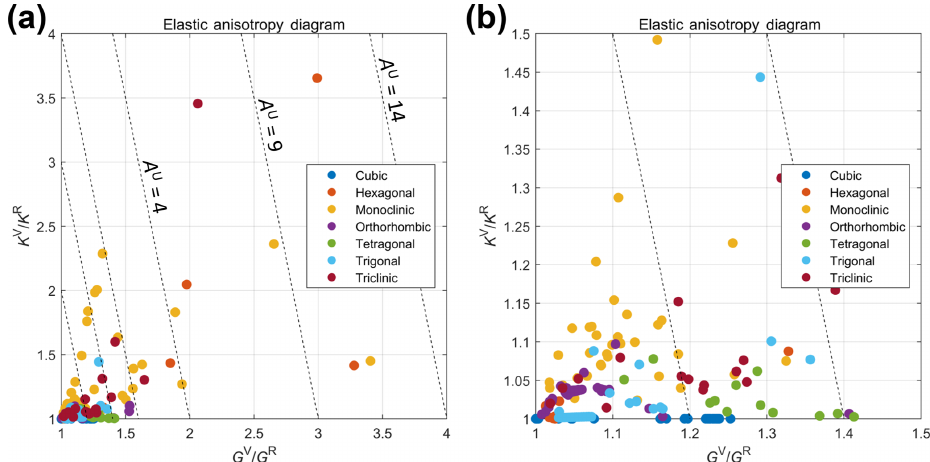
Figure 17. (a) Anisotropy of rock-forming minerals ( n = 246) using the elastic anisotropy diagram used in materials science, grouped by mineral symmetry class. (b) Close-up of the data plotted in (a) with G V /G R in the range of 1 to 1.5 and K V /K R in the range of 1 to 1.5.